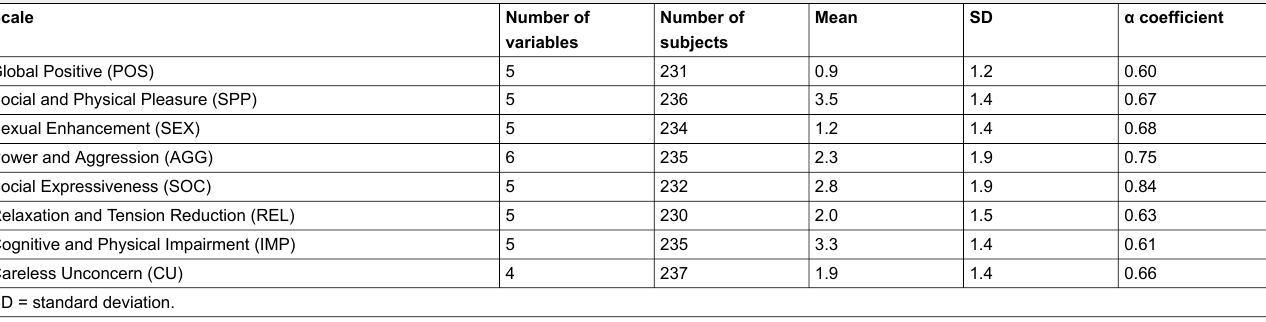
Table 3 : Relationships between alcohol expectancies (measured by the Alcohol Effects Questionnaire (AEFQ)) and drinking problems (measured by the alcohol use disorders identification test (AUDIT)) among soldiers – multinomial logistic regressions (n = 201). Alcohol misuse